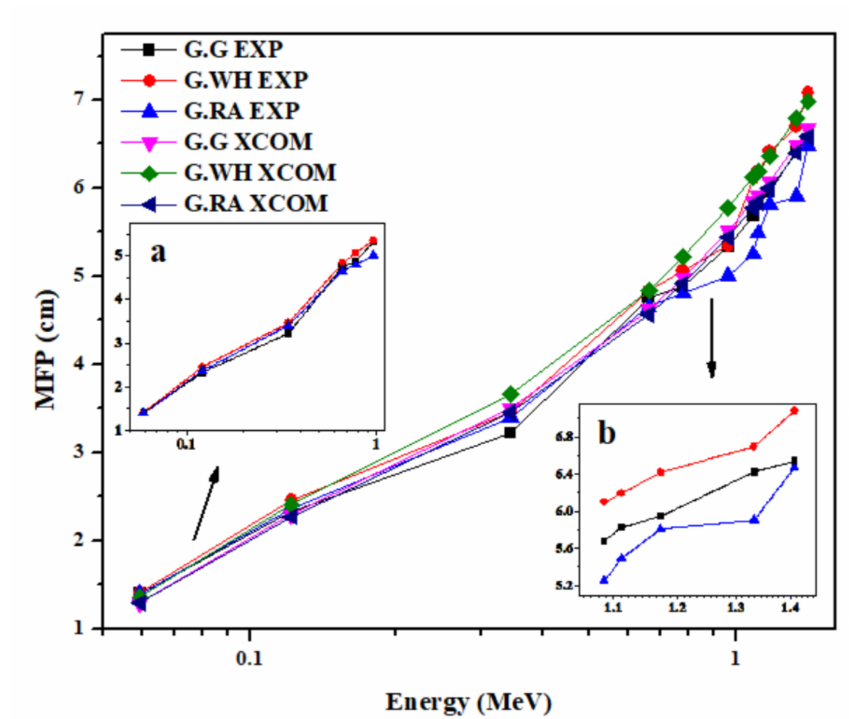
Figure 4. Variation of the experimental and theoretical values of the mean free path (MFP) with pho- ton energy for the granite samples in the energy range 0.015 to 15 MeV. Insets ( a , b ) to the figure show the variation of the experimentally obtained MFP in the low and high energy ranges,